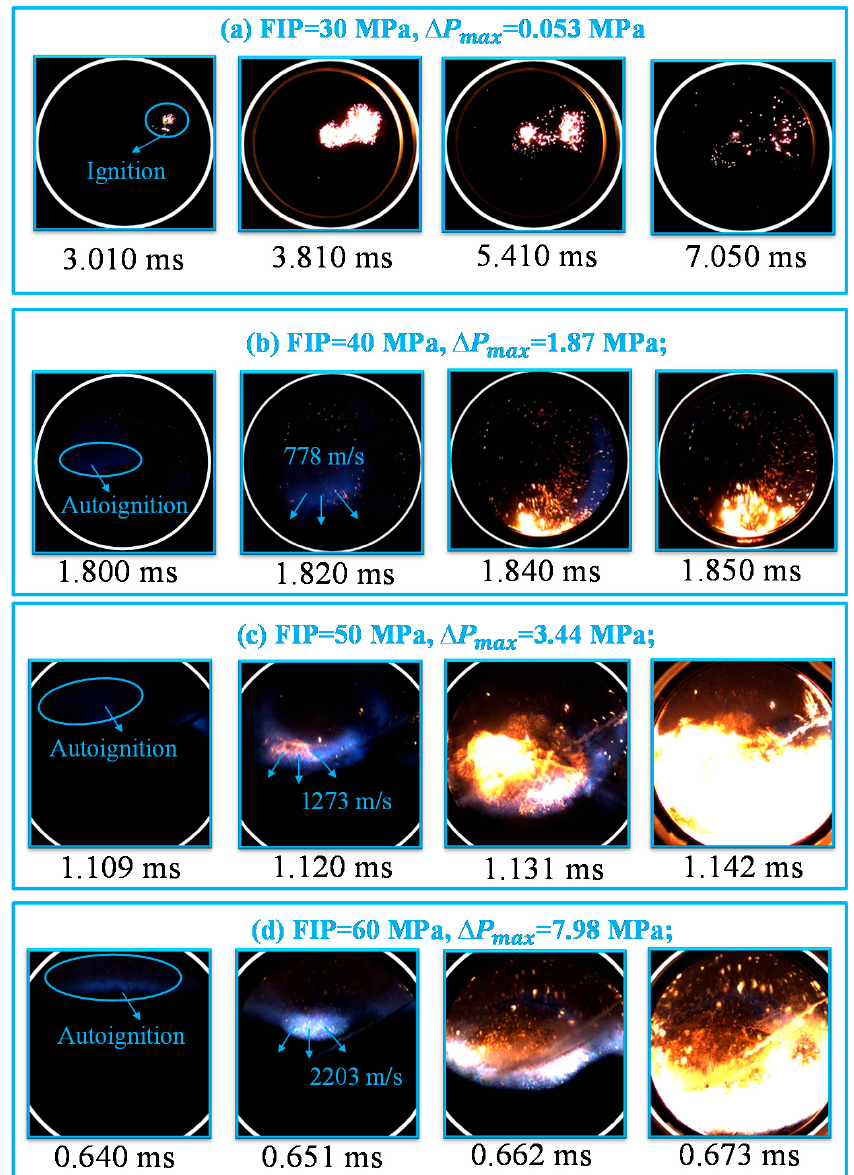
Figure 8. Selected images of combustion evolution under the conditions of T c = 930.8 K, P c = 2.14 MPa, ∆ t = 1.5 ms: ( a ) FIP = 30 MPa, ∆ P max = 0.053 MPa; ( b ) FIP = 40 MPa, ∆ P max = 1.87 MPa; ( c ) FIP = 50 MPa, ∆ P max = 3.44 MPa; ( d ) FIP = 60 MPa, ∆ P max = 7.98 MPa.